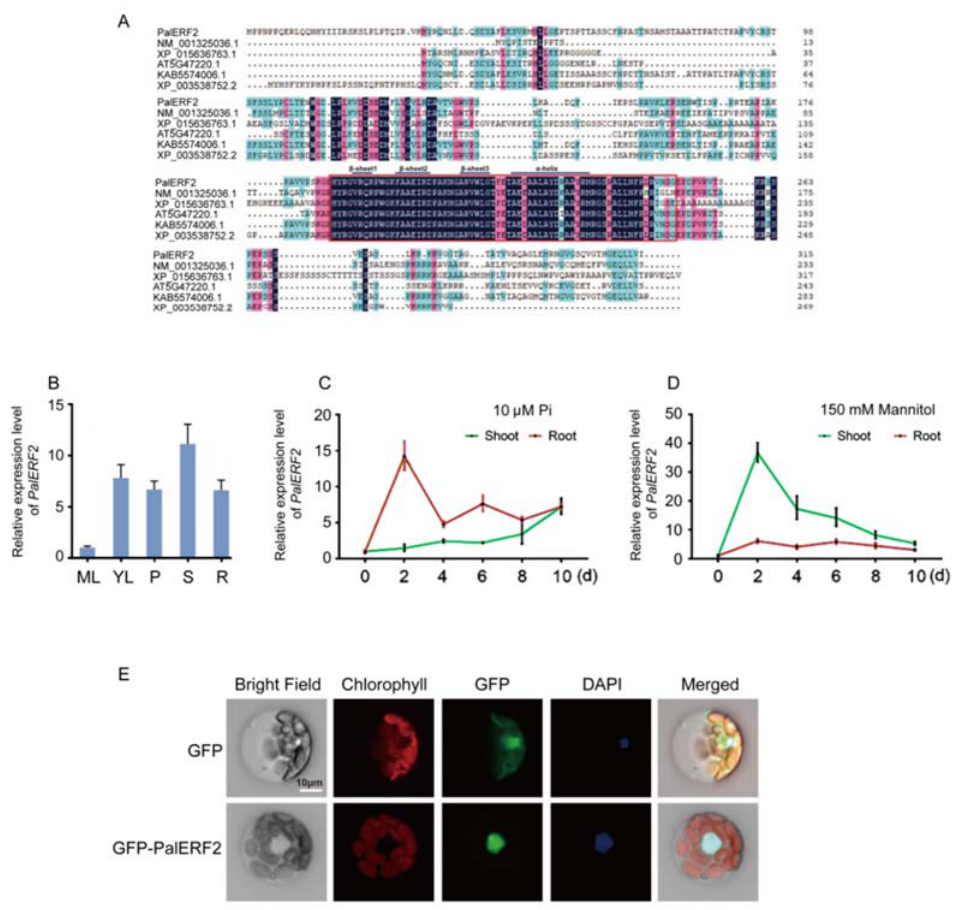
Figure 1. Characteristics of PalERF2 of Populus alba var. Pyramidalis. ( A ) Multiple sequence alignment of ERFs and the accession numbers are derived from different species (NM_001325036.1 from Nicotiana tabacum , XP_015636763.1 from rice, AT5G47220.1 from Arabidopsis thaliana , KAB5574006.1 from Salix brachista, and XP_003538752.2 from Glycine max ). ( B ) The qRT-PCR analysis of PalERF2 expression in root (R), stem (S), mature leaves (ML), young leaves (YL), and petiole (P) in the mediums of MS. ( C , D ) The temporal expression pattern of PalERF2 under low Pi treatment (10 µ M Pi) and 150 mM mannitol treatment in shoot and root, respectively. Error bars indicate SD values from three biological replicates. ( E ) Subcellular localization of PalERF2 in the mesophyll protoplasts of P. alba var. pyramidalis . The empty vector pBI221 ‐ expressing GFP is used as control (upper row) and the PalERF2 ‐ GFP fusion proteins are localized in the nucleus only (lower row). DAPI staining indicates the nucleus.